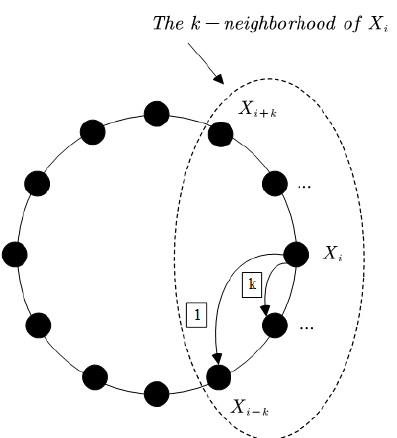
Figure 6. The attraction model in the RN topology